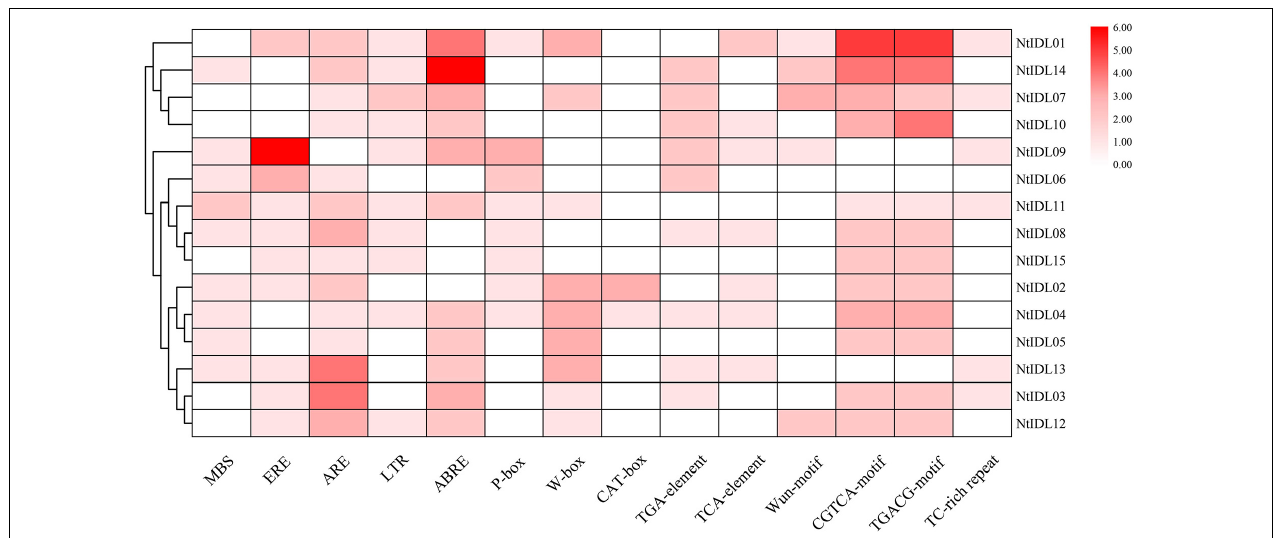
FIGURE 2 | Regulatory elements in the promoter regions of NtIDL gene promoters. The color represents the numbers of cis -element in NtIDL gene promoters. MBS (MYB binding site involved in drought-inducibility), ERE (ethylene-responsive cis -acting), ARE (anaerobic induction element), LTR (low-temperature-responsive element), ABRE ( cis- acting element involved in the abscisic acid responsiveness), P-box (gibberellin-responsive element), W-box (WRKY binding site), CAT-box ( cis- acting regulatory element related to meristem expression), TGA-element (auxin-responsive element), TCA-element ( cis- acting element involved in salicylic acid responsiveness), Wun-motif (wound-responsive element), CGTCA-motif ( cis- acting regulatory element involved in the MeJA-responsiveness), TGACG-motif ( cis- acting regulatory element involved in the MeJA-responsiveness), and TC-rich repeats (involved in defense and stress